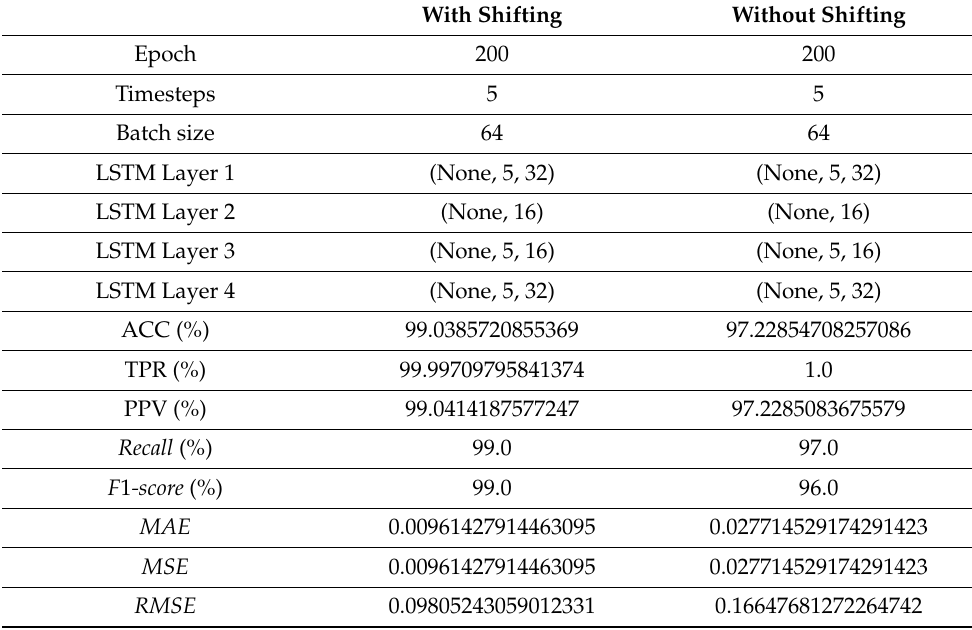
Table 5. RoMADS model results with the shift and without the shift.